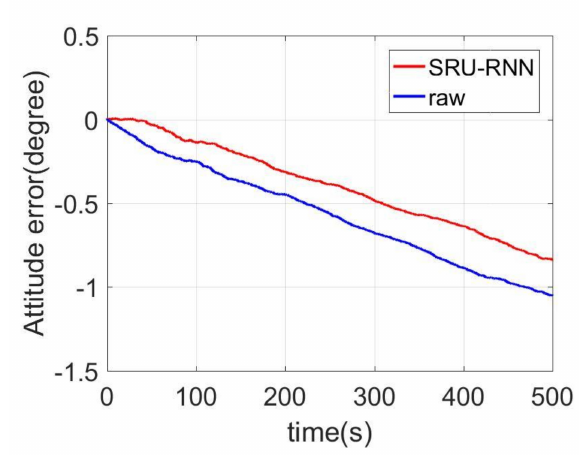
Figure 15. Pitch